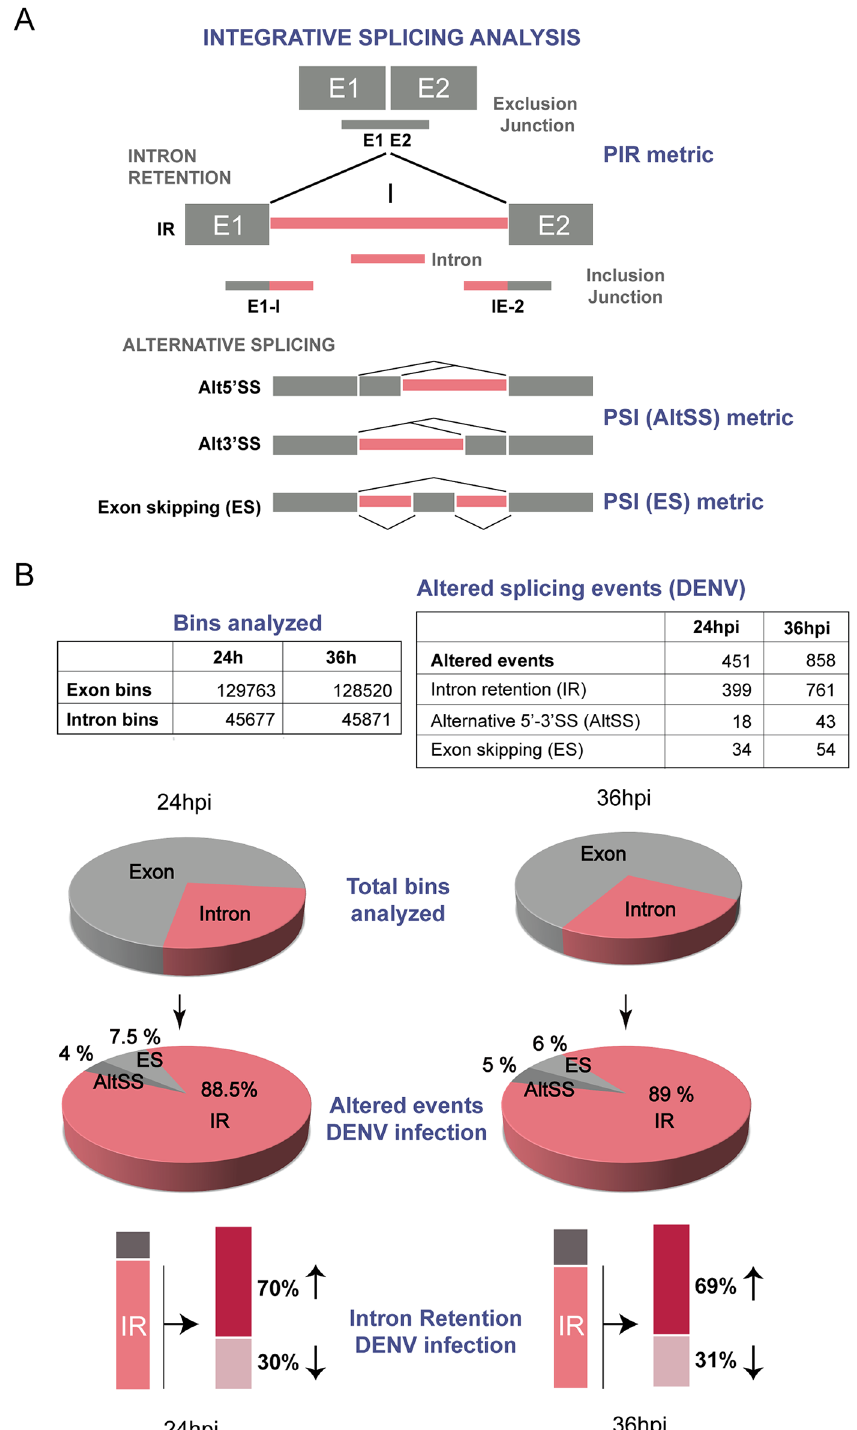
Fig 8. Decreased splicing efficiency in DENV infected cells. (A) Schematic representation of splicing analysis. The four splicing events analyzed are shown: Intron retention (IR), Exon skipping (ES), Alternative splice site donor/acceptor (Alt5 ’ SS and Alt3 ’ -SS). Constitutive exon and alternative 5 ’ and 3 ’ SS regions are shown in grey and intron regions in pink. For intron retention the information of the junctions (E1-I, IE-2 and E1E2) was used to calculate the PIR metric. For ES and AltSS the PSI metric was used (see Materials and methods). (B) Data of splicing analysis of DENV or mock infected cells. On the upper panels, total amount of